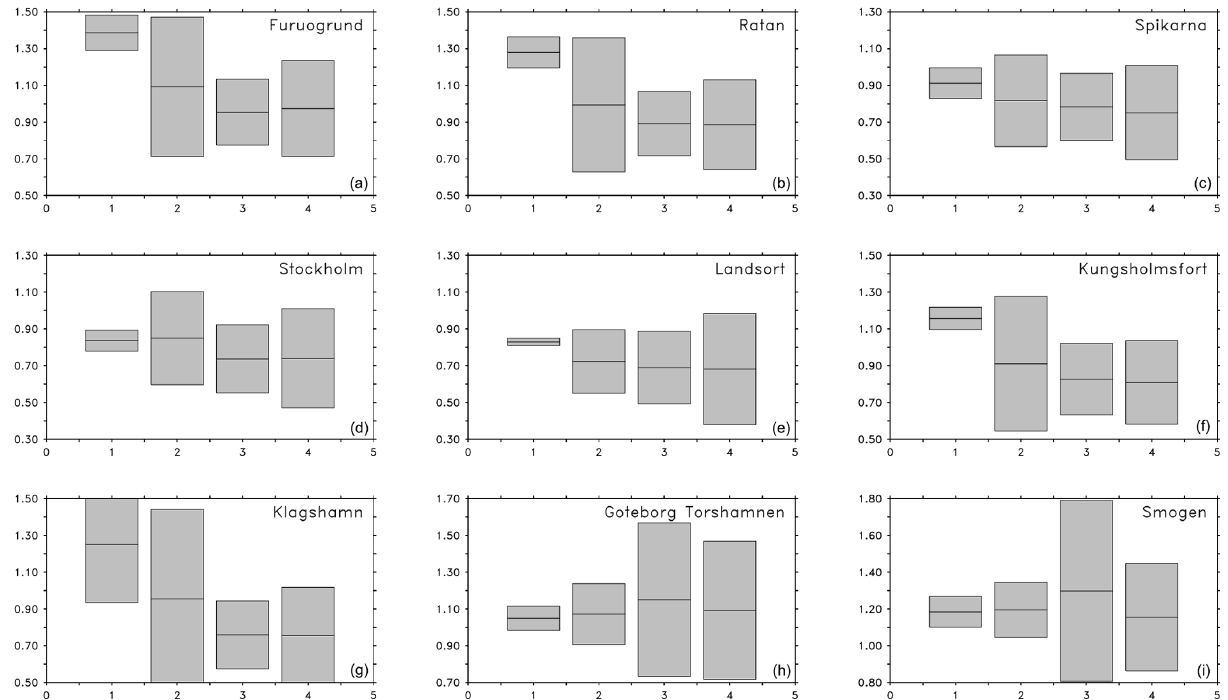
Figure 3. Sensitivity of ESLs using different sets of experiments. Extreme sea levels (m) with 100-year return period for the same stations as in Fig. 2. The different sets of experiments are decadal variability (1), atmospheric forcing (2), open boundary conditions (3) and model parameters (4). The horizontal line represents the mean of the different estimates and the lightly shaded area around it is the 95% confidence interval. Table 5. Sensitivity experiments with different atmospheric forcing for different RCMs. RCA4-NEMO-1hr ERA40 is the same setup as RCA4-NEMO ERA40 but the atmosphere and ice–ocean components are coupled every hour. NEMO-Nordic ERA40 and NEMO-Nordic ERA-Interim are two ocean-only setups forced with the output of RCA4 ERA40 and RCA4 ERA-Interim, respectively. NEMO-Nordic interpolated is the same setup as NEMO-Nordic ERA40 but with linearly interpolated forcing (see text for more details). NEMO-Nordic 3.6 ERA40 and NEMO-Nordic 3.6 EURO4M (Hordoir et al., 2019) are two of the ocean-only setups forced with ERA-40 and EURO4M,